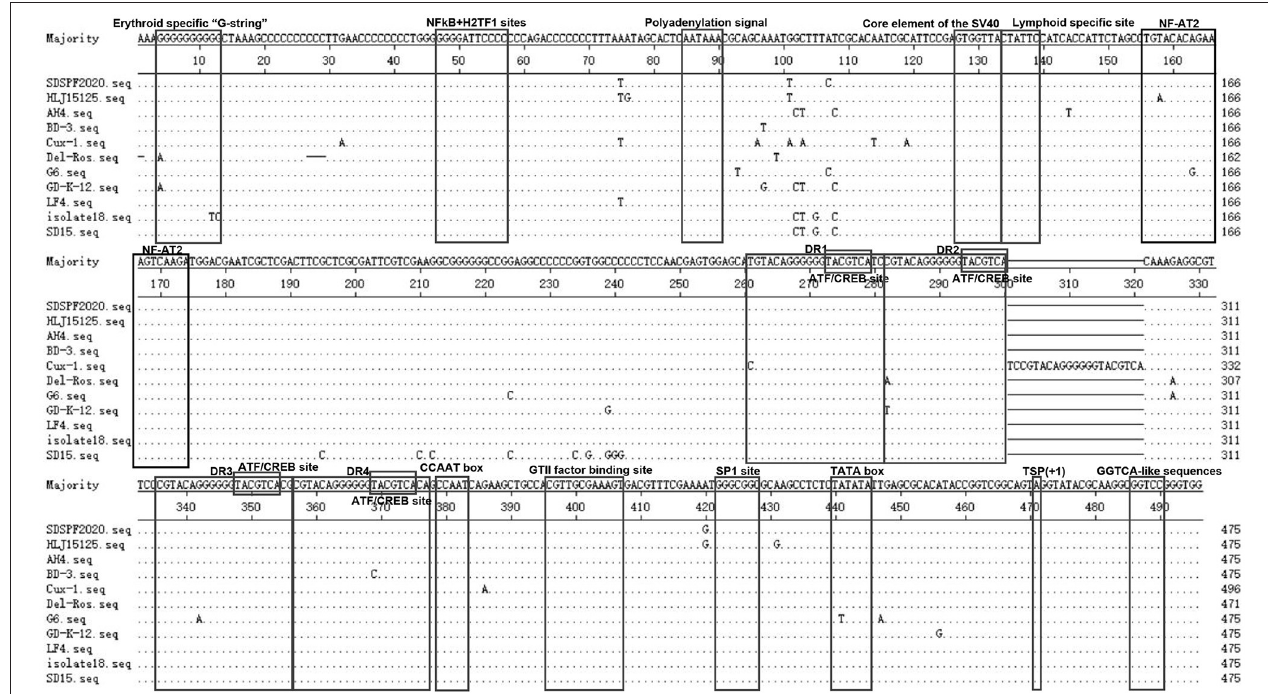
FIGURE 4 | Sequence alignment of the non-coding region sequences of SDSPF2020 and 10 reference strains. The sequences in black frames are the motifs of transcriptional regulatory elements in this study. Nucleotides matching the consensus are indicated with dots and nucleotide differences are indicated with letters.